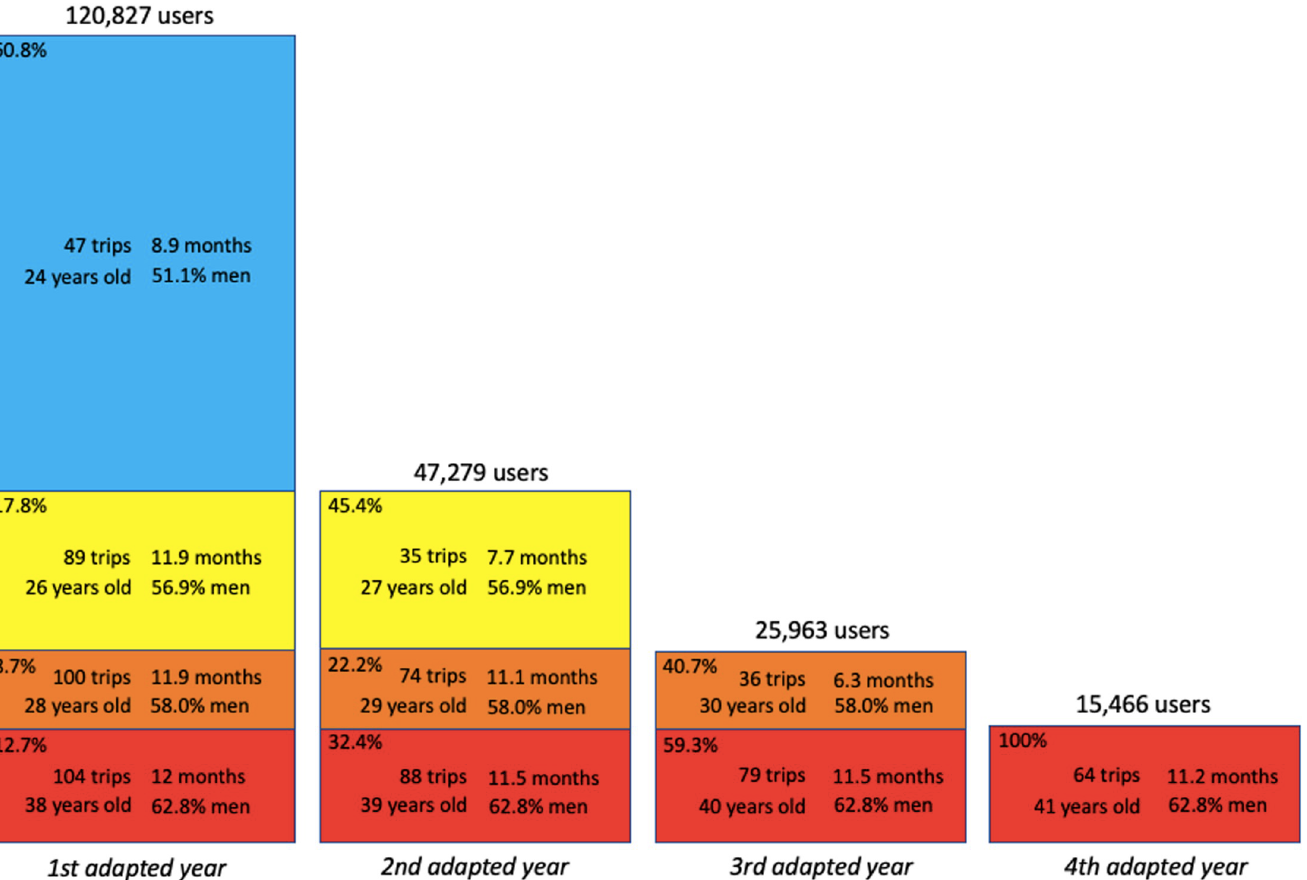
Fig 2. Percentages of users leaving the system at the end of different adapted years. For each group of users, we give the median number of trips per year, the median number of active months, the median age and the percentage of men. For example, ‘blue users’, which stopped at the end of their first adapted year, represented 60.8% of first year users, 51.1% were men, and were characterized by the following median numbers: 8.9 months of activity, 47 trips, 24 years old. Yellow users stopped at the end of their second adapted year. They had a median number of trips during their first year of 89 and during their second year of 35. They stopped after 7.7 active months during their second year. The figures for other users can be read from the figure.